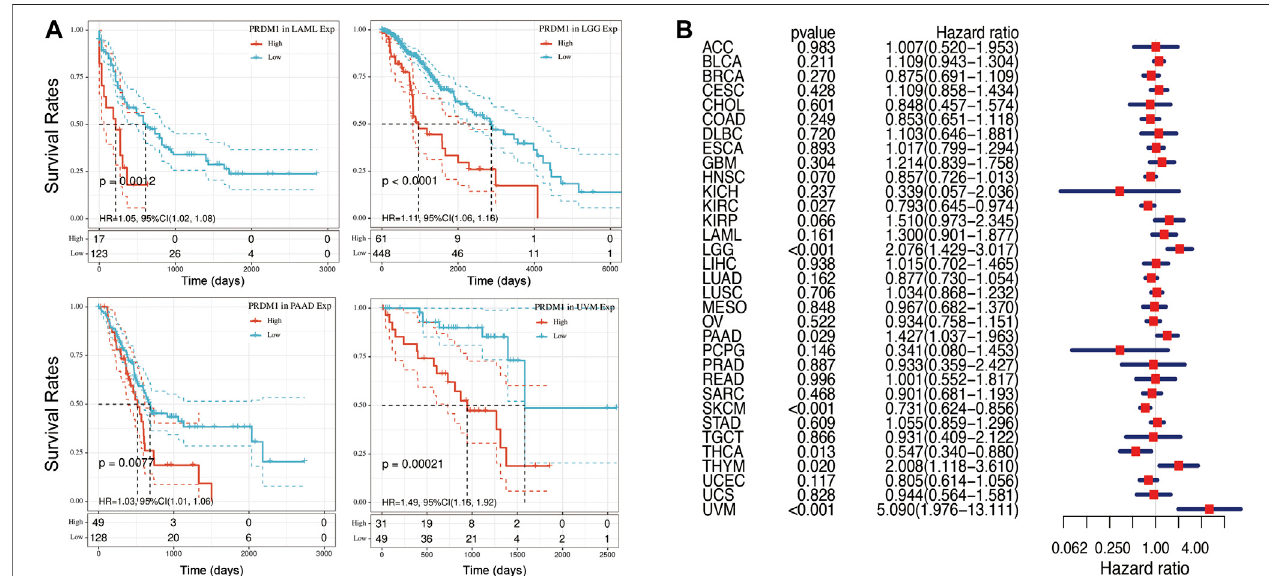
FIGURE 2 | Selected Kaplan-Meier plots and forest plot comparing the high and low expression of PRDN1 on overall survival across different cancers (A) Kaplan- Meier Method showed high expression of PRDM1 correlated with unfavorable prognosis in LAML, LGG, PAAD, UVM (B) Forest plot displaying the impact of high expression of PRDM1 on OS across thirty three cancer types using Cox regression model.